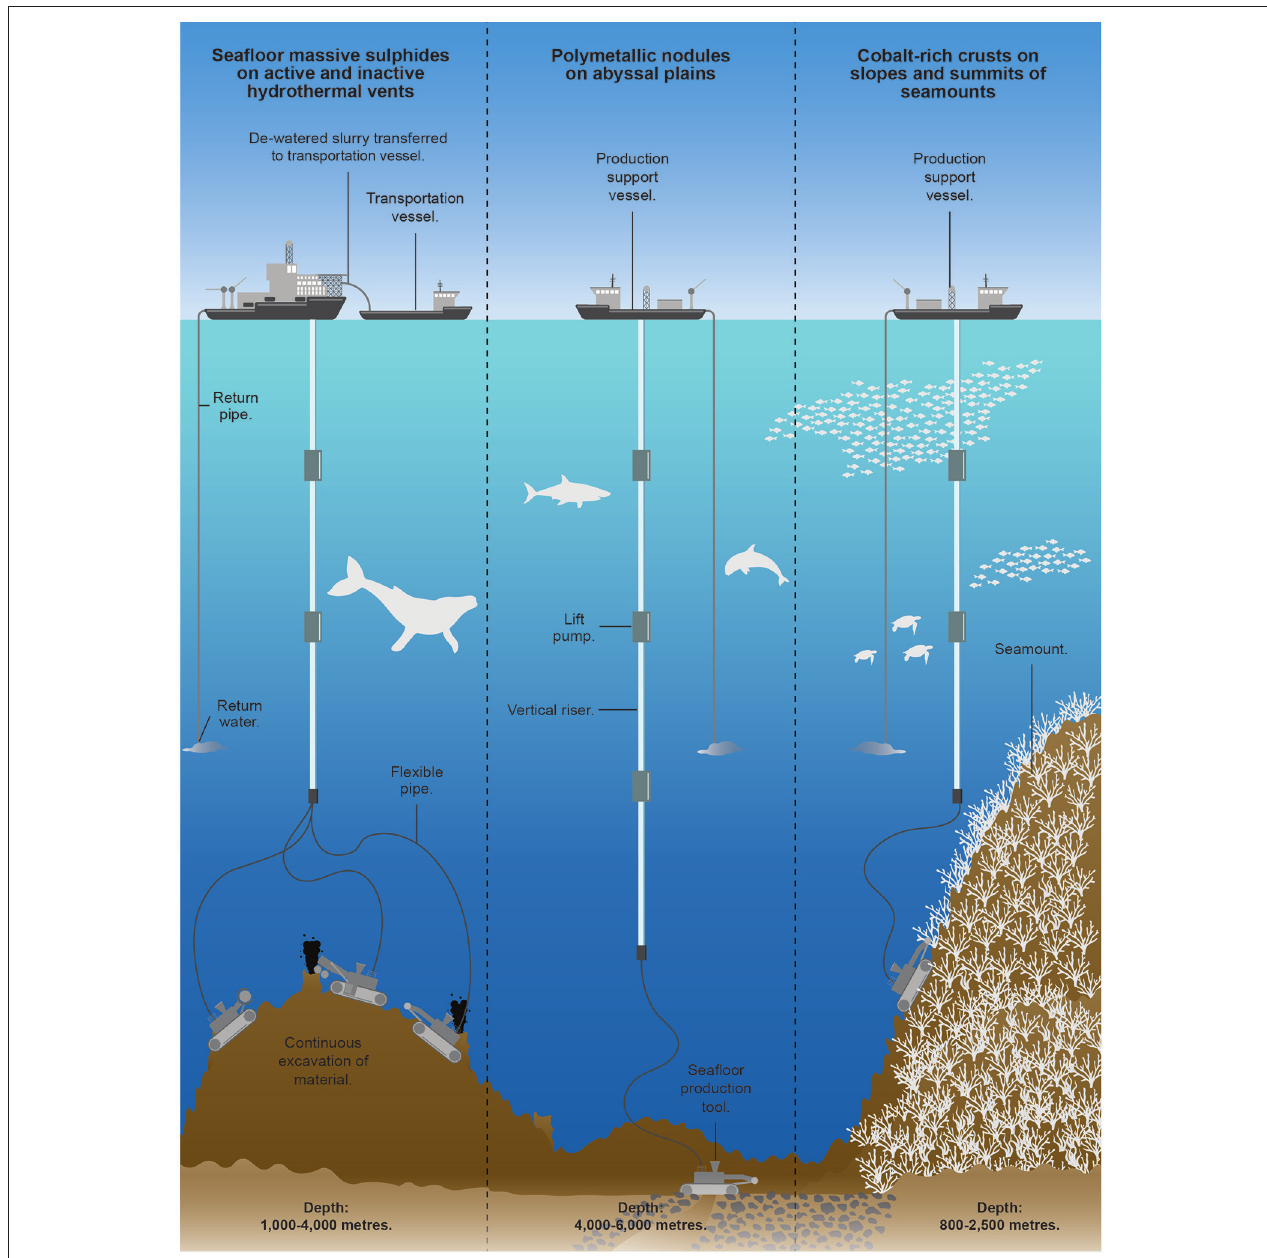
FIGURE 4 | A schematic showing the processes involved in deep-sea mining for the three main types of mineral deposit. Schematic not to scale.